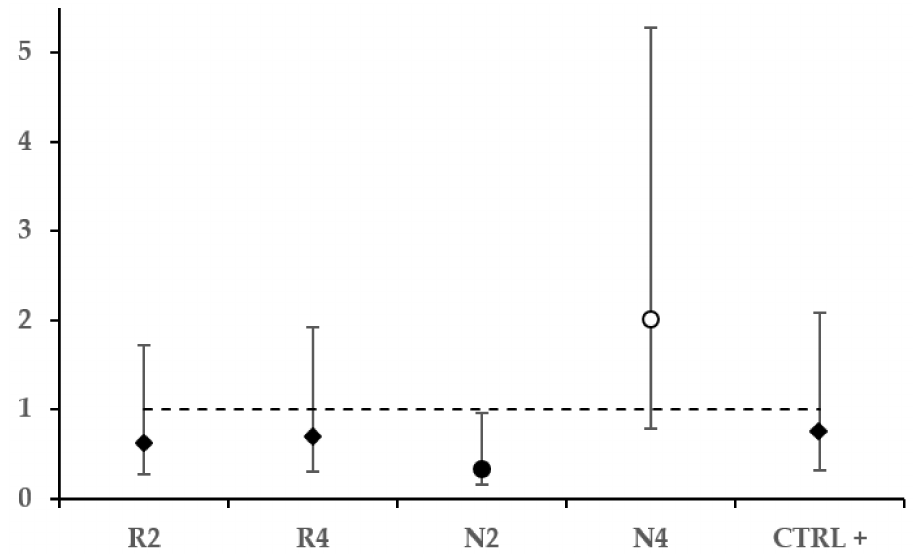
Figure 4. Hazard ratios represented along with the respective confidence interval for each experi- mental N. ceranae -infected treated group (R2, R4, N2, N4) and CTRL+. The CTRL − served as the reference group. The dotted line indicates HR = 1. Significantly lower, higher, and non-significant HR values are, respectively, indicated by a black circle, white circle, and diamonds.